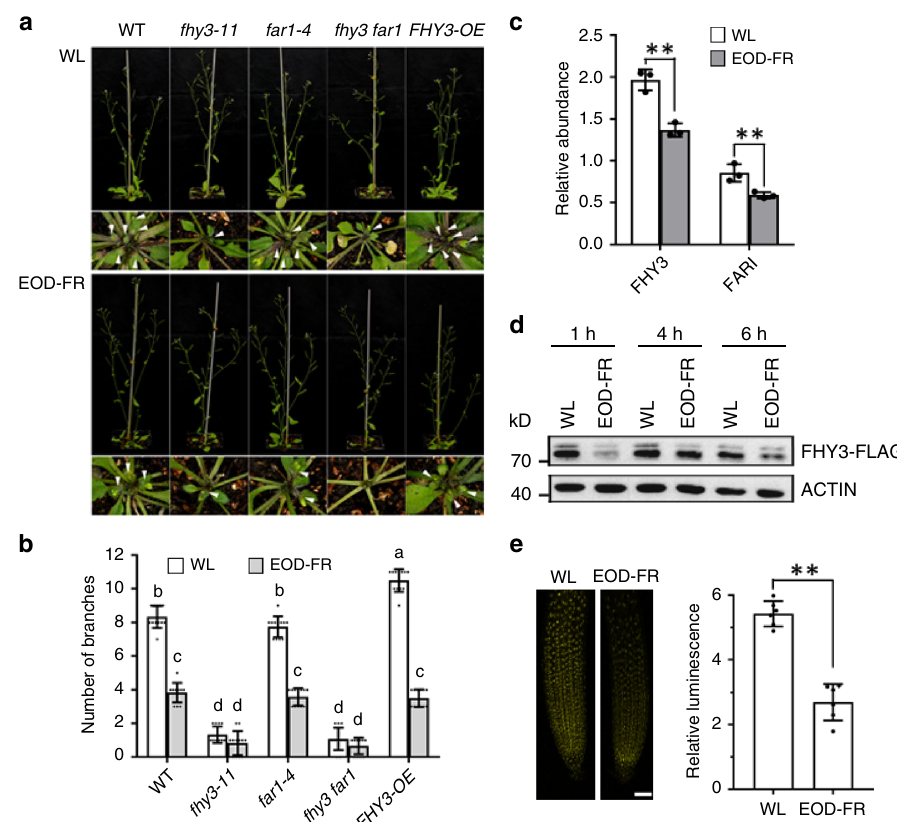
Fig. 1 FHY3 and FAR1 play a role in regulating branching in response to light quality change. a Comparison of the rosette branch number of fhy3-11 , far1- 4 , fhy3 far1 , FHY3 overexpressor, and WT plants grown under normal conditions (WL) or stimulated shade conditions (EOD-FR). Eight-day-old seedlings were moved into the soil and grown under WL with or without EOD-FR treatment for 4 weeks before phenotyping. Arrow indicates the short rosette branches. b Quanti fi cation of the number of rosette branches of fhy3-11 , far1-4 , fhy3 far1 , FHY3 overexpressor, and WT plants grown under WL or EOD-FR conditions. Values shown are mean ± SD ( n = 12). Letters indicate signi fi cant differences by two-sided LSD test ( p < 0.05). c The transcript levels of FHY3 and FAR1 are downregulated by EOD-FR treatment. Seven-day-old seedlings grown under WL conditions were treated with or without EOD-FR for 30 min and then harvested for RNA extraction. Values shown are mean ± SD ( n = 3). ** p < 0.01 by two-sided Student t test. d Western blotting assay showing that both FHY3 protein level rapidly declined in seedlings treated with EOD-FR. Anti-FLAG antibodies were used to detected FHY3 protein and actin was adopted as a loading control. This assay was repeated for three times and similar results were obtained. e Fluorescence microscopic analysis of FHY3-YFP protein levels. This assay was repeated for three times and similar results were obtained. The relative fl uorescence intensity was quanti fi ed by measuring the fl uorescence pixel intensity using software Image J. Values shown are mean ± SD ( n = 6). ** p < 0.01 by two-sided Student t test. Scale bar = 50 μ